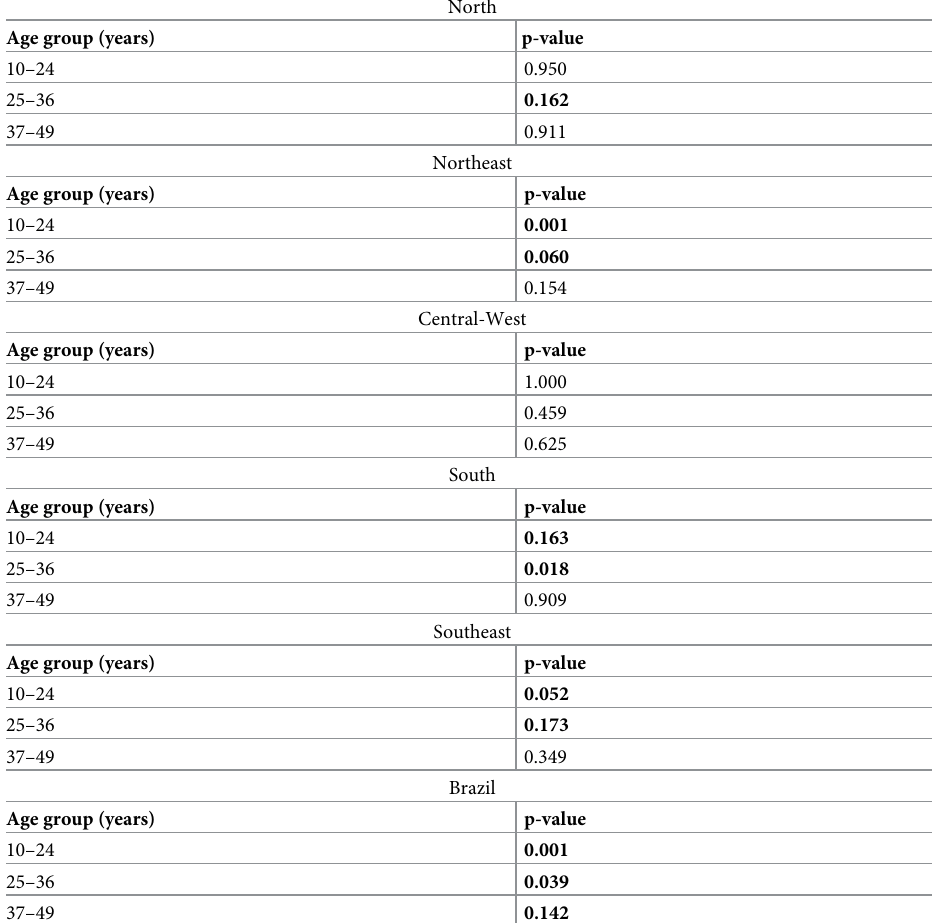
Table 2. Description of the interaction terms between the year of occurrence of death and age group at the regional and national levels, Brazil,